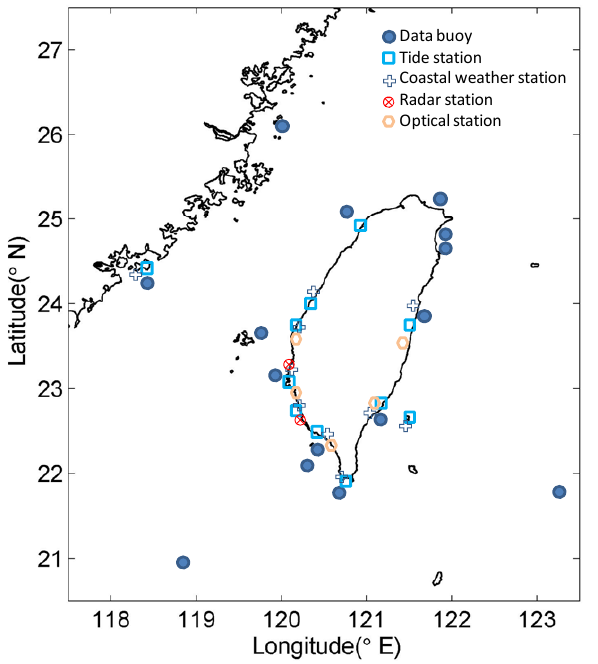
Figure 4 Coastal and ocean monitoring network in Taiwan Waters Fig. 4. Coastal and ocean monitoring network in Taiwan Waters.